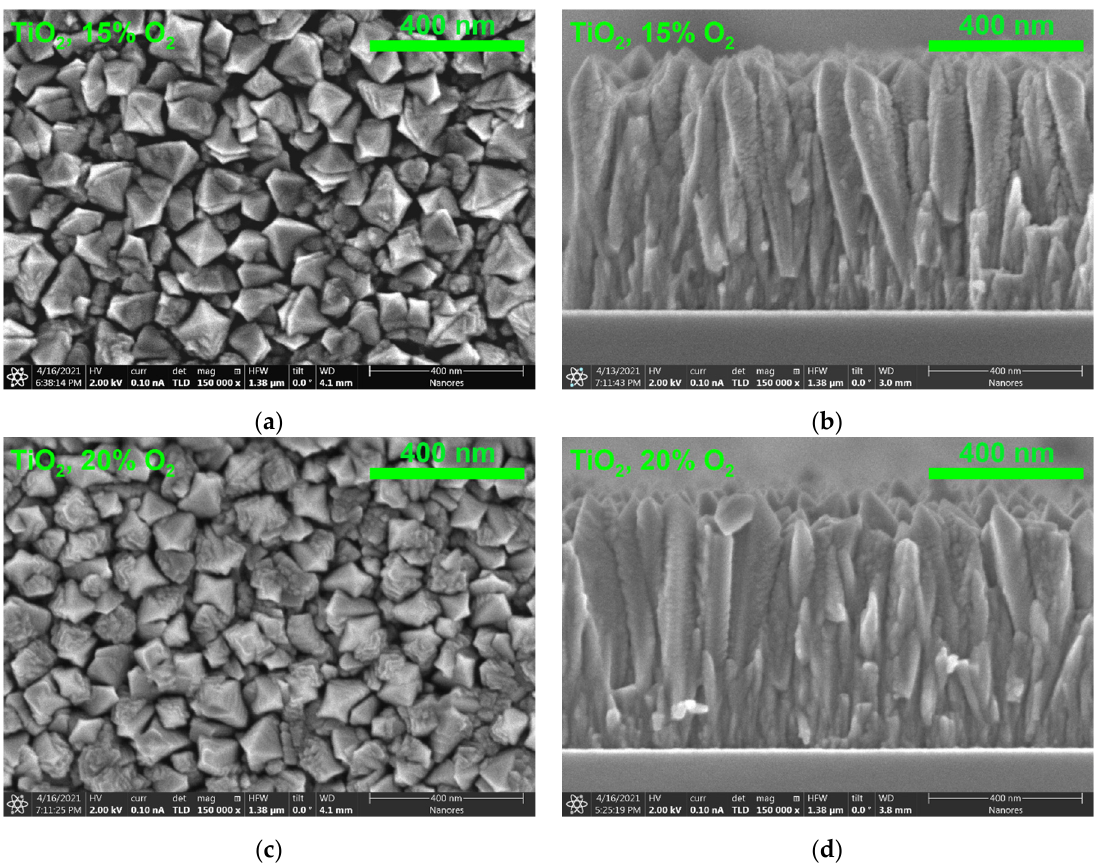
Figure 2. SEM images of the surface and cross-section of undoped TiO 2 thin films deposited at ( a , b ) 15% O 2 and ( c , d ) 20% O 2 .